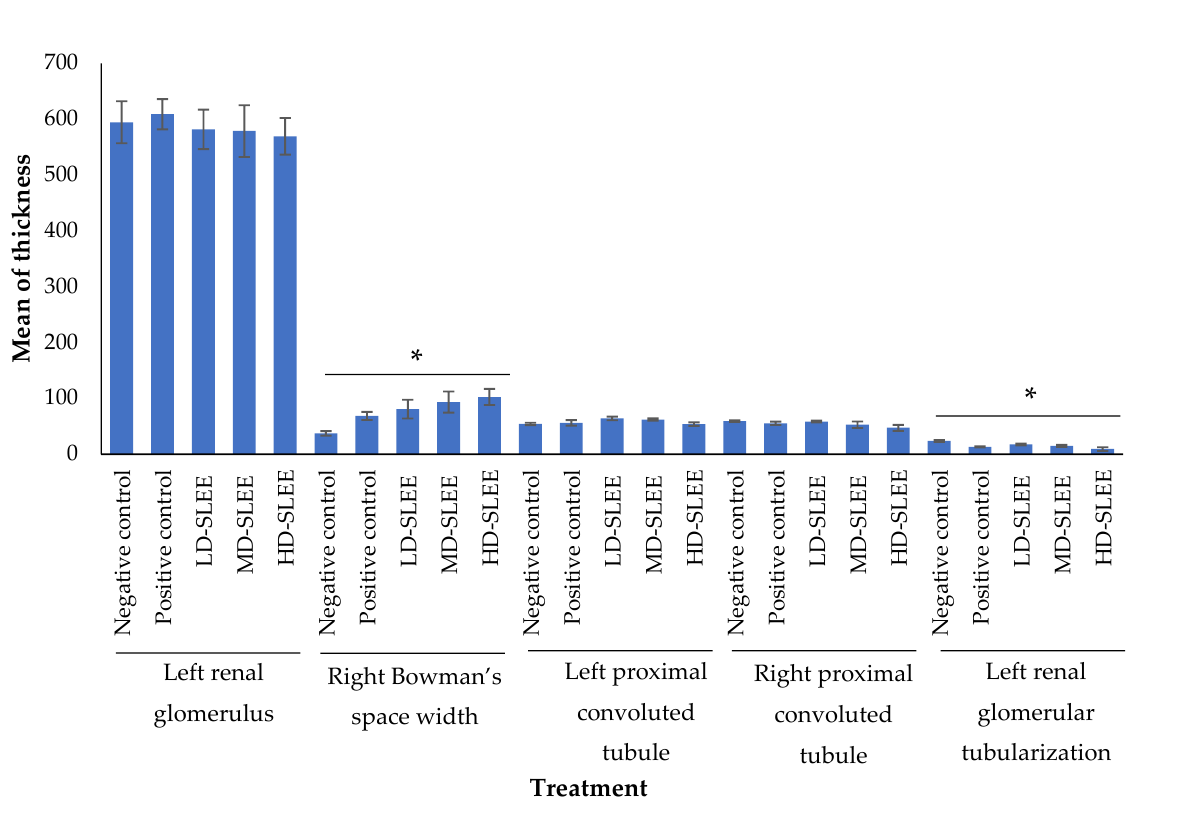
Figure 5. One-way ANOVA test results from some variables of left and right kidneys in the treatment mice groups. * p < 0.05 indicated significantly different results. LD-SLEE = low-dose ethanol extract of soursop leaf; MD-SLEE = medium-dose ethanol extract of soursop leaf; HD-SLEE = high-dose ethanol extract of soursop leaf.